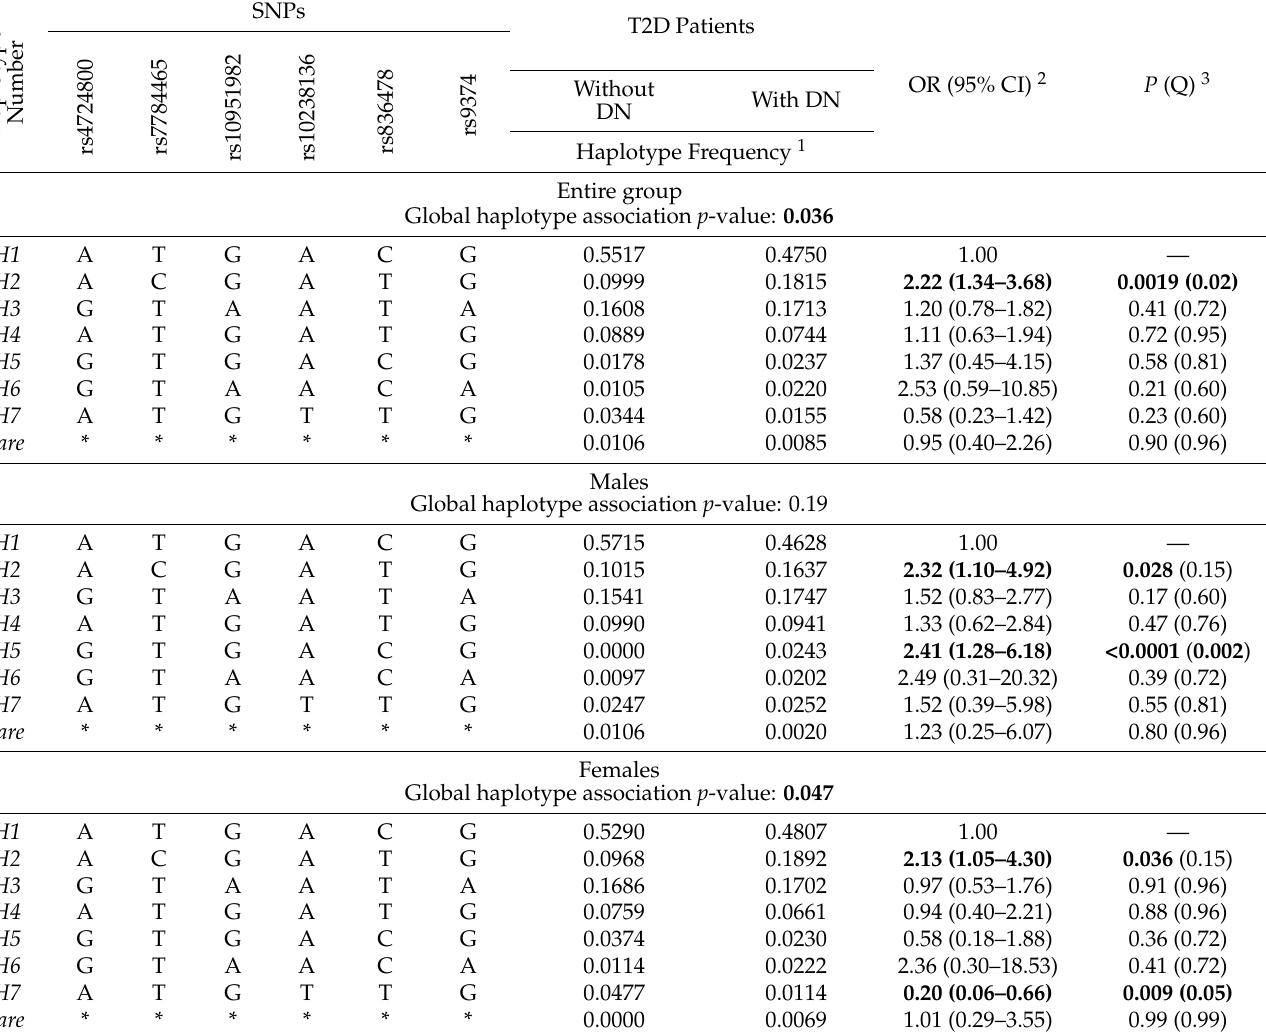
Table 6. Estimated common haplotype frequencies of RAC1 gene in T2D patients with and without diabetic